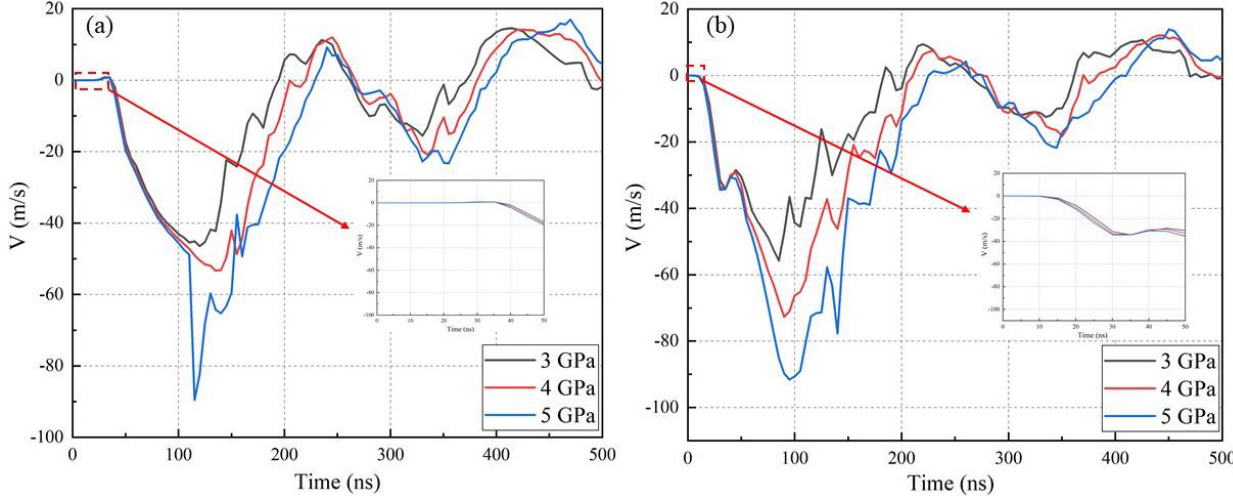
Figure 7. Velocity evolution of the embossment top ( a ) and bottom ( b ) at different peak pressures.